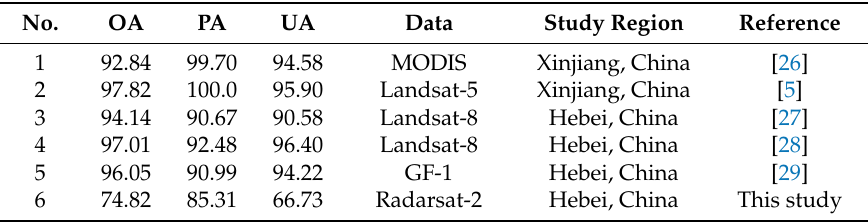
Table 11. Accuracies of the existing results.